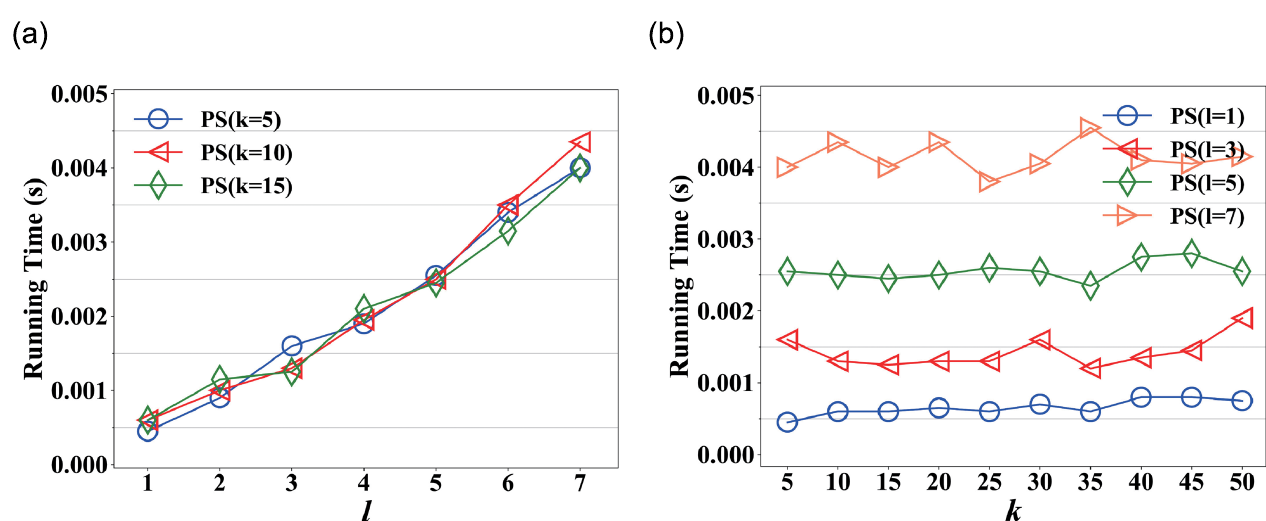
Fig 7. Running time on varying l and k respectively in ImageNet. (a) Running time on varying l , (b) Running time on varying k .